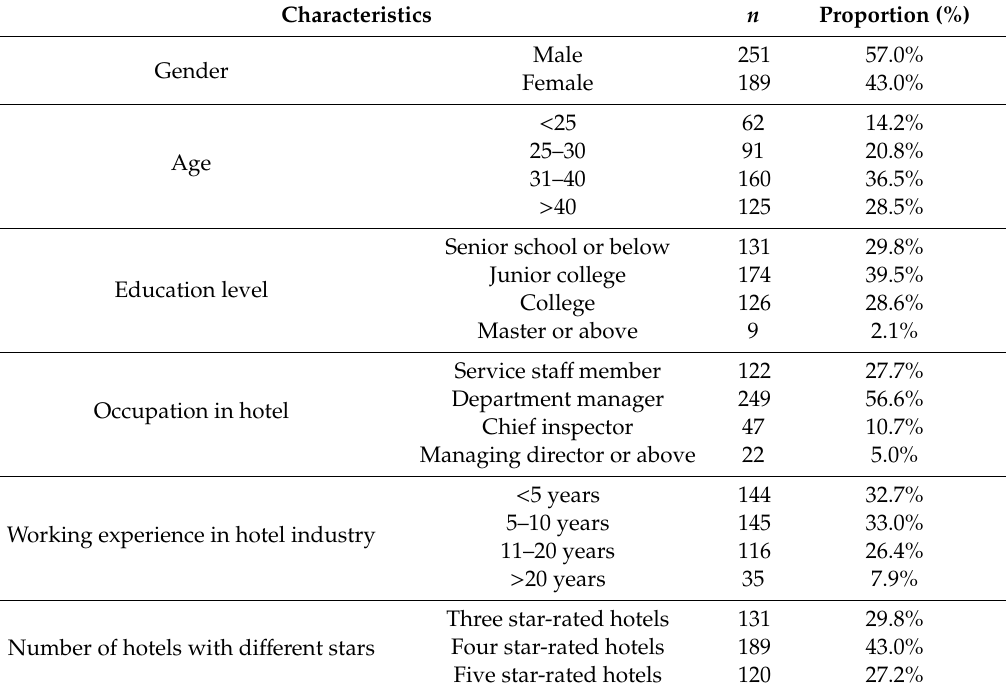
Table 4. Summary of respondent socio-demography ( n =